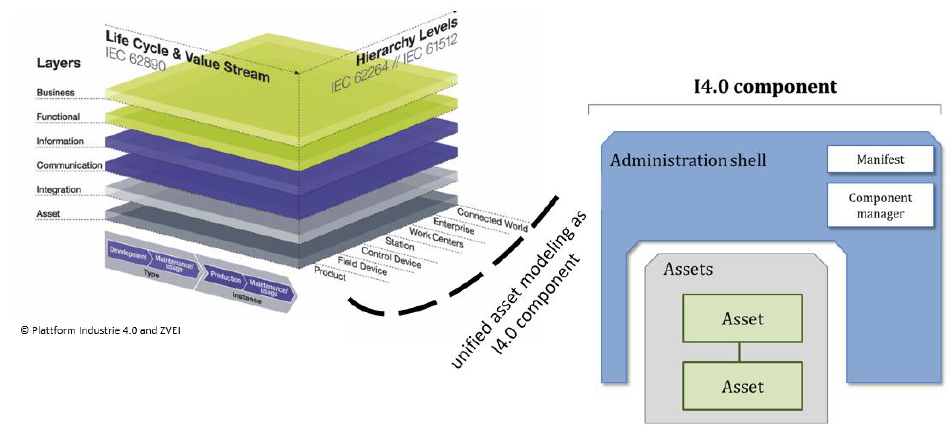
Figure 5. Main Industrie 4.0 concepts: RAMI4.0 and I4.0 component (graphics of the figure taken from Reference [3]).